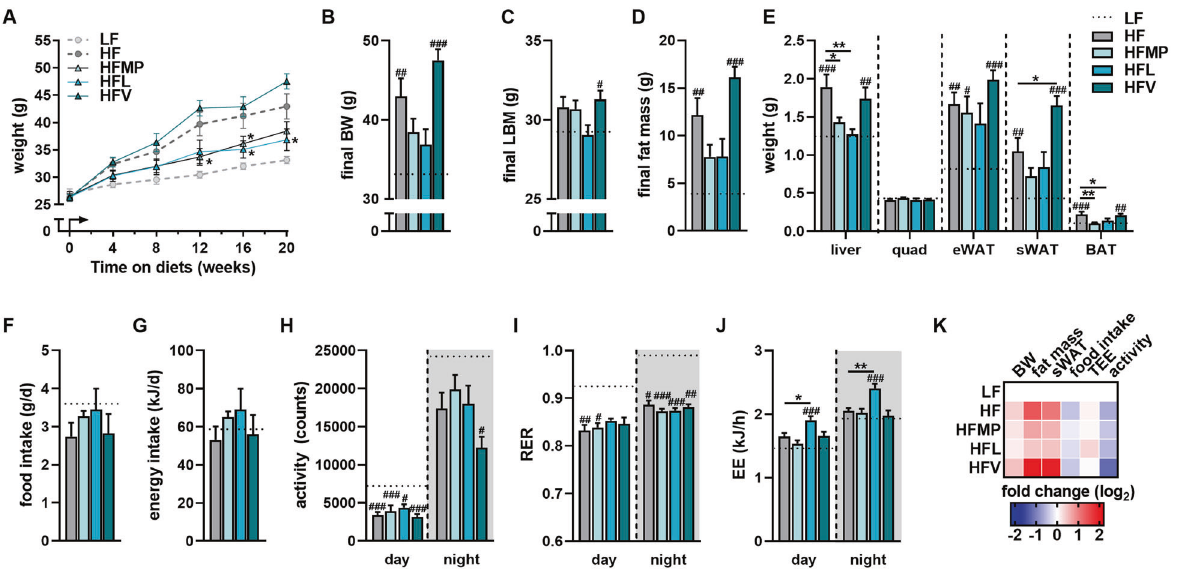
Fig. 1 Valine feeding drives adiposity under high-fat diet conditions. A Body weight development in male C57BL/6 JRj mice fed low-fat (LF), high-fat (HF), or experimental HF diets supplemented with milk protein (HFMP), leucine (HFL), or valine (HFV) for 20 weeks ( n = 12). B Final body weight at 20 weeks ( n = 12). C Final calculated lean body mass ( n = 12). D Final fat mass determined with NMR ( n = 12). E Final tissue weights for liver, muscle and adipose tissue depots ( n = 12). F Average food intake per day over 24 h ( n = 5 – 7). G Calculated energy intake per day from average food intake and energy content of diets. ( n = 5 – 7). H Average locomotor activity (beam breaks) x1000 per 12 h period (day and night phase) ( n = 7). I Respiratory exchange ratio (RER; n = 8). J Average energy expenditure (EE) per hour per 12 h period (day and night phase) ( n = 8). K Heatmap of phenotypic effects. Data are mean + SEM, LF is represented as dotted line. * p < 0.05; ** p < 0.01; *** p < 0.001 compared to HF and # p < 0.05; ## p < 0.01; ### p < 0.001 compared to LF. BW body weight, LBM lean body mass, eWAT epididymal white adipose tissue, sWAT subcutaneous white adipose tissue, BAT brown adipose tissue, quad quadriceps